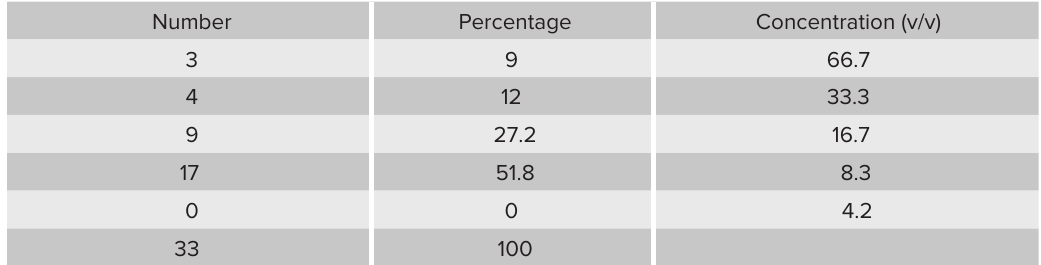
Table 5: Frequency of MBC of 33 Species of Honey-Sensitive Staphylococcus aureus